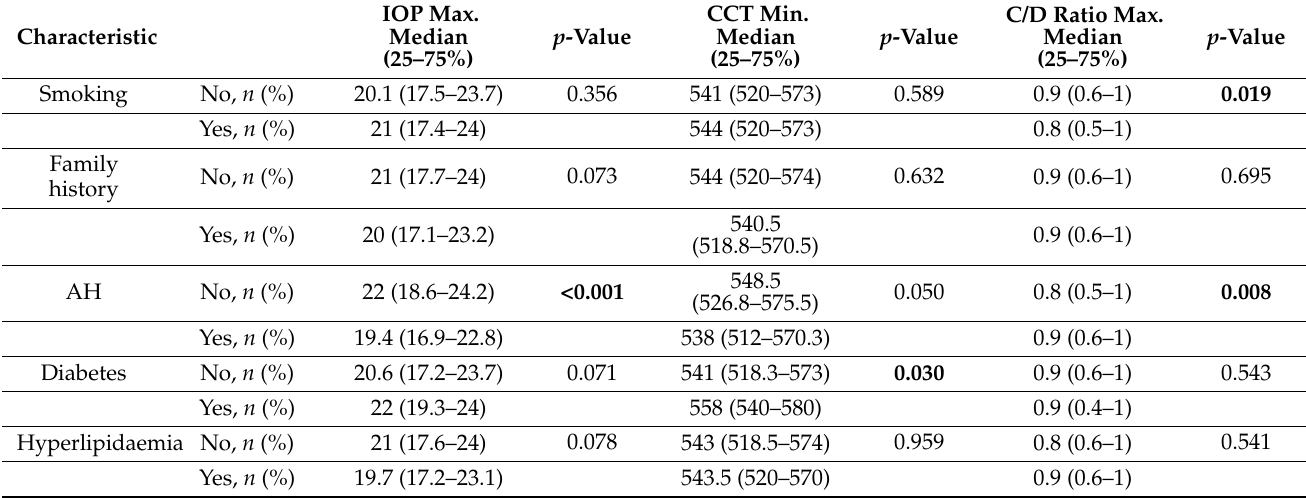
Table 6. Association of patients’ clinical characteristics with the glaucoma